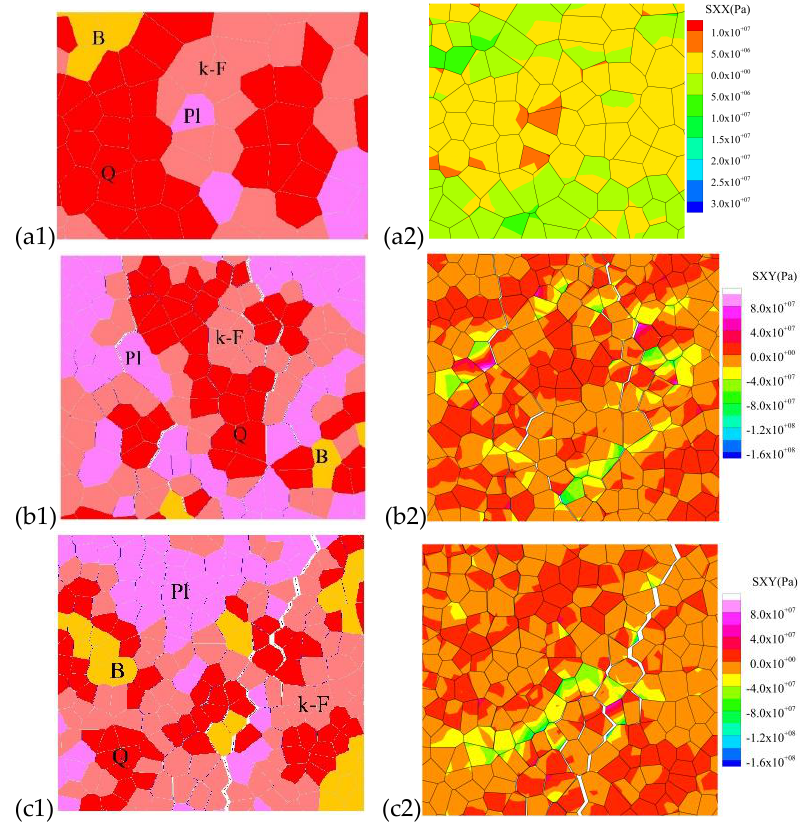
Figure 16. Local typical grain-scale block stress fracture characteristics and stress cloud diagram at different damage stages. ( a1 , a2 ) In Stage III, the grain boundary tensile failure stress cloud diagram; ( b1 , b2 ). In Stage IV, mixed intragranular the failure stress cloud diagram; ( c1 , c2 ). In Stage V and VI, the macroscopically penetrating failure stress cloud diagram.